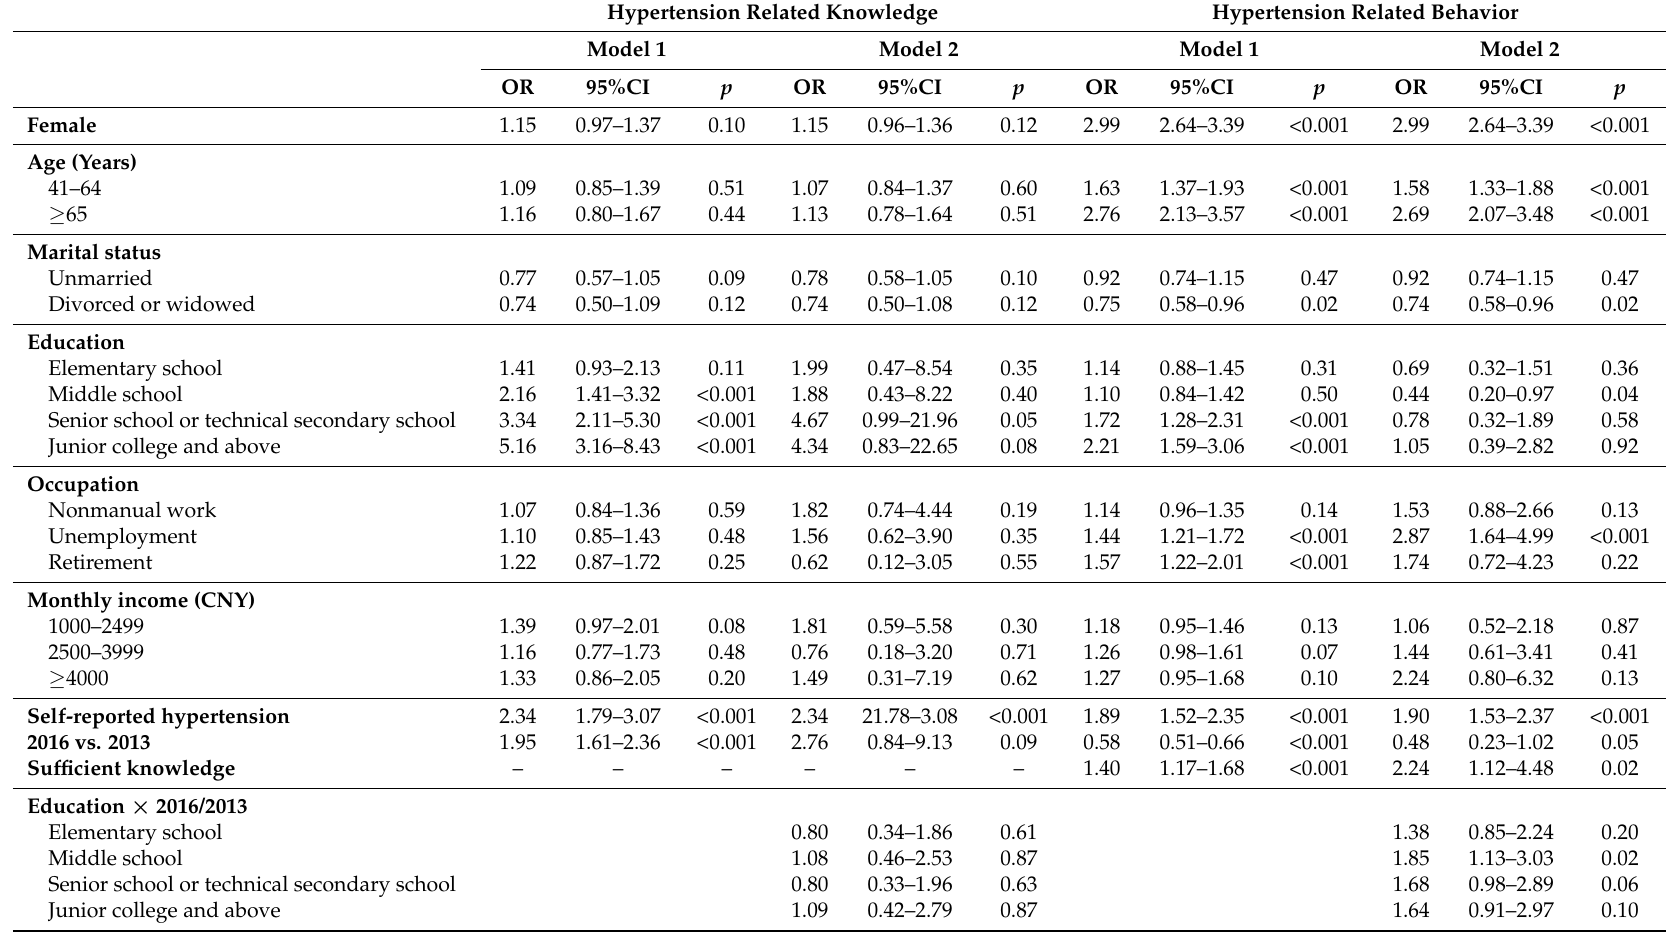
Table 4. Logistic regression analysis of hypertension related knowledge and behavior with interact